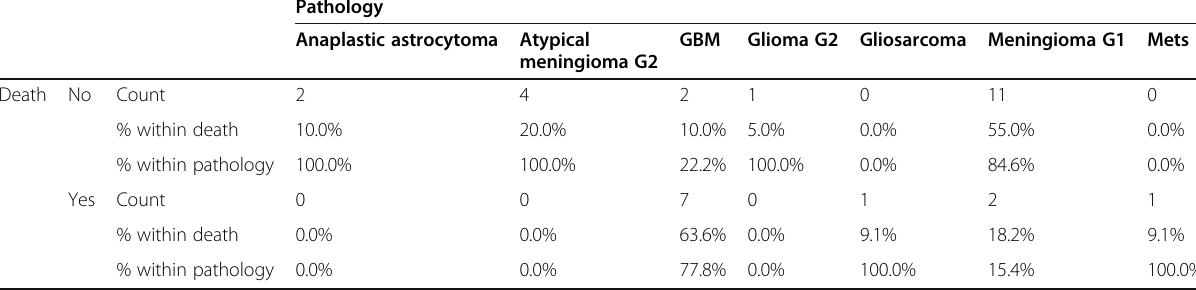
Table 2 The relationship between mortality and pathology